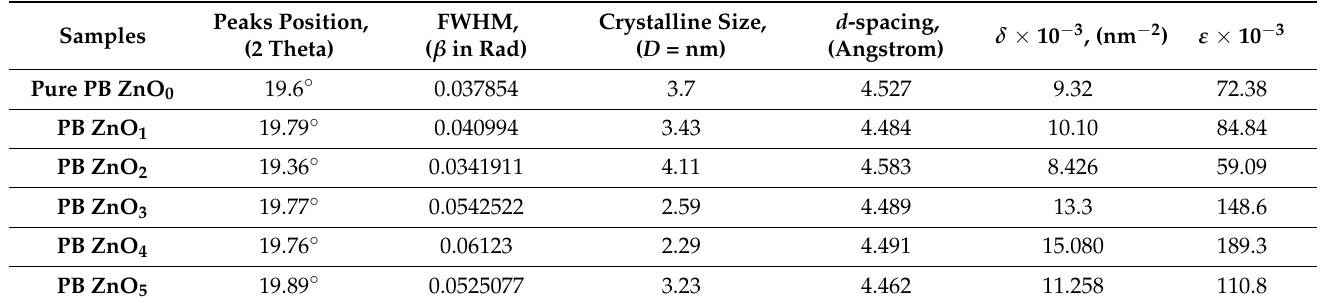
Table 1. The calculated values of crystalline size ( D ), d -spacing, dislocation density ( δ ), and strain length ( ε ) of the PVA/PVP doped in ZnO nanocomposite